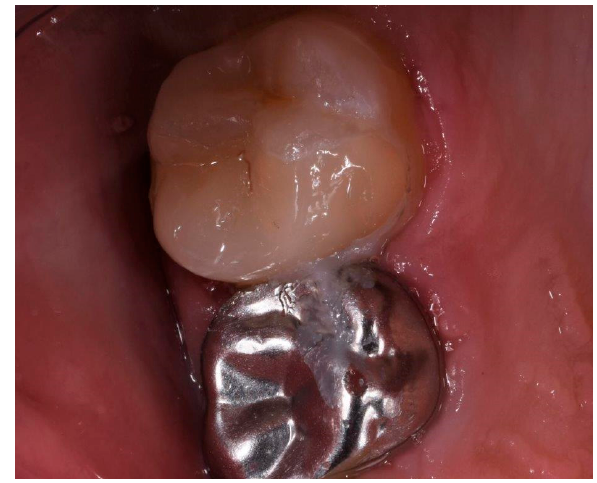
Figure 7. Cementation of restoration.